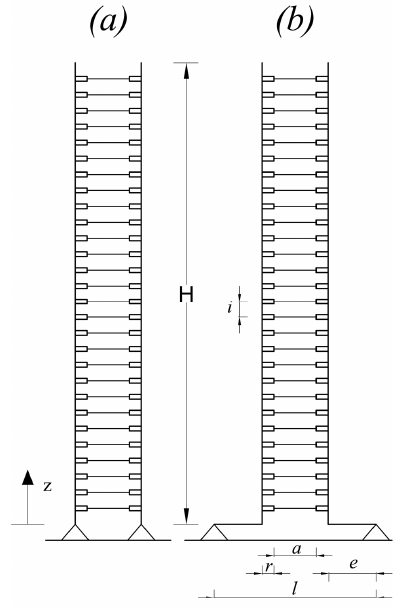
Figure 1. Dissipative Column Model: ( a ) Model A: Hinged at the ends; ( b ) Model B: Eccentrically Hinged at the